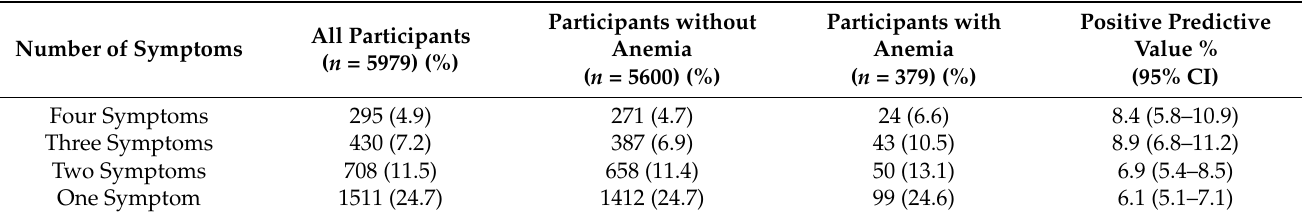
Table 6. Number of symptoms in subgroups and positive predictive value of anemia symptoms, weighted percentages.